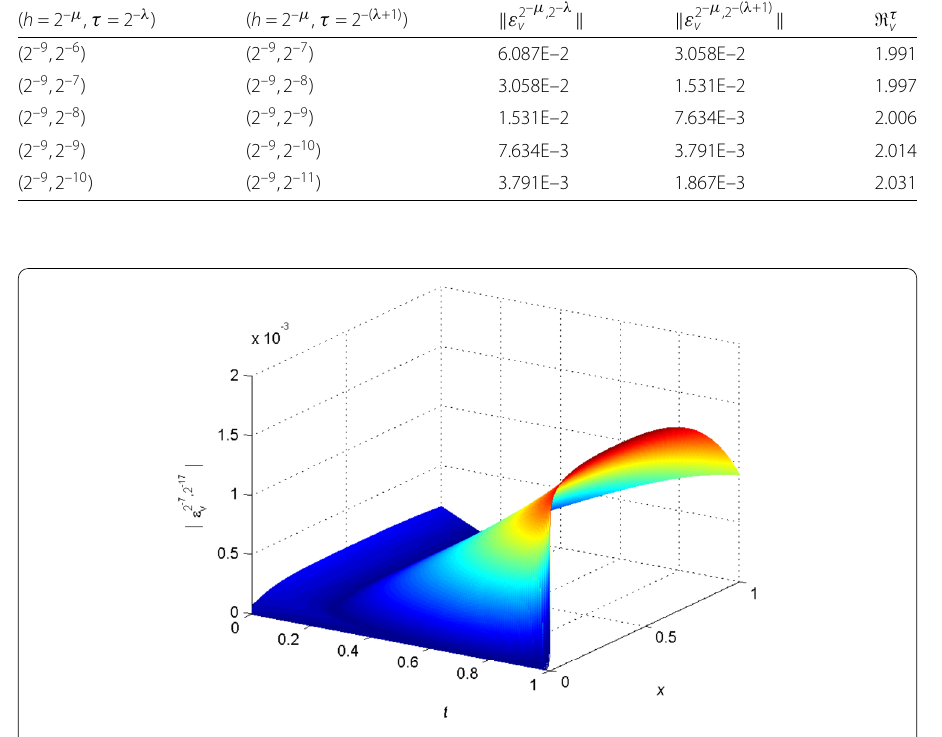
2–7,2–17 | = | (cid:11) v – v | for h = 2 –7 , and τ = 2 –17 for Example 1 v